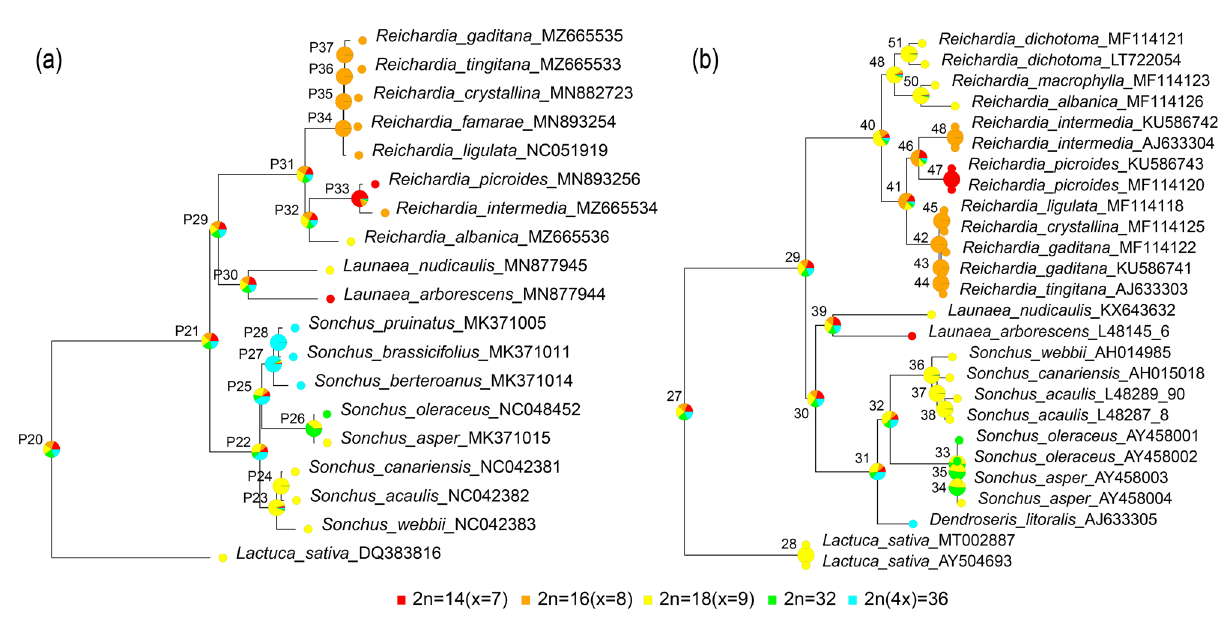
Figure 8. The ancestral states and shared-derived karyotypes reconstructed using MrBayes Ancestral States with R (MBASR) mapped on the ML trees based on ( a ) plastome and ( b ) nrDNA ITS sequences. The tree plots overlay state marginal likelihood pie charts at each lineage split for the probabilities of each basic chromosome